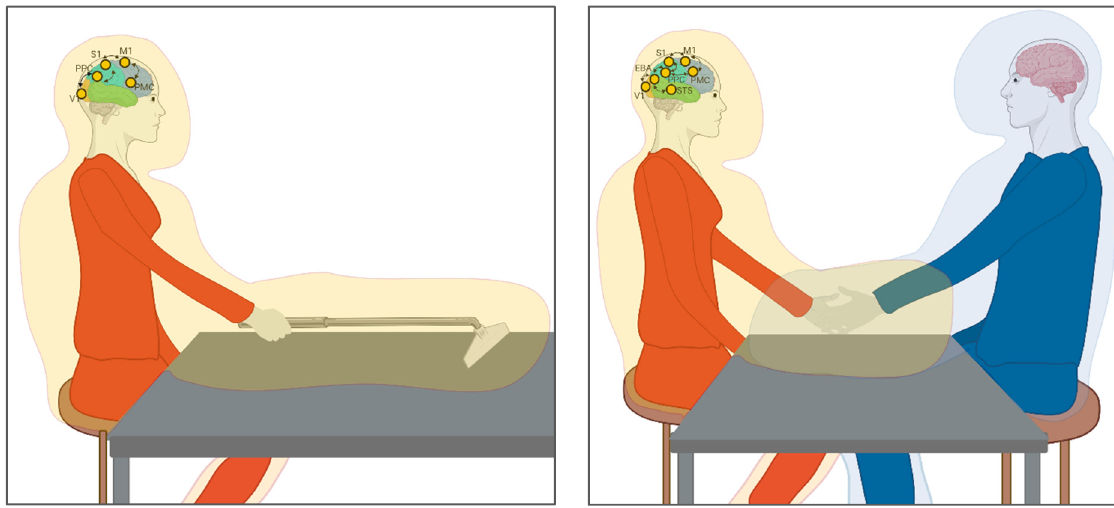
Figure 1. Plastic changes in the peripersonal space (PPS) during tool-use and interpersonal motor interactions. Left panel : Incorporation of a tool in own PPS during active tool use. Right panel : The same mechanism could underlie the incorporation of the partners’ limb during motor interactions (i.e., handshake), to facilitate interpersonal coordination. The neural network involves feedforward and feedback projections between visual (V1, Extrastriate Body Area (EBA), Superior Temporal Sulcus (STS)), somatosensory (S1), and motor (M1) areas, as well as multisensory areas involved in representing the PPS, i.e., the posterior parietal cortex (PPC) and premotor cortex (PMC). The orange/blue shadow represents the PPS expanded around the tool or partner (Created with Biorender.com).